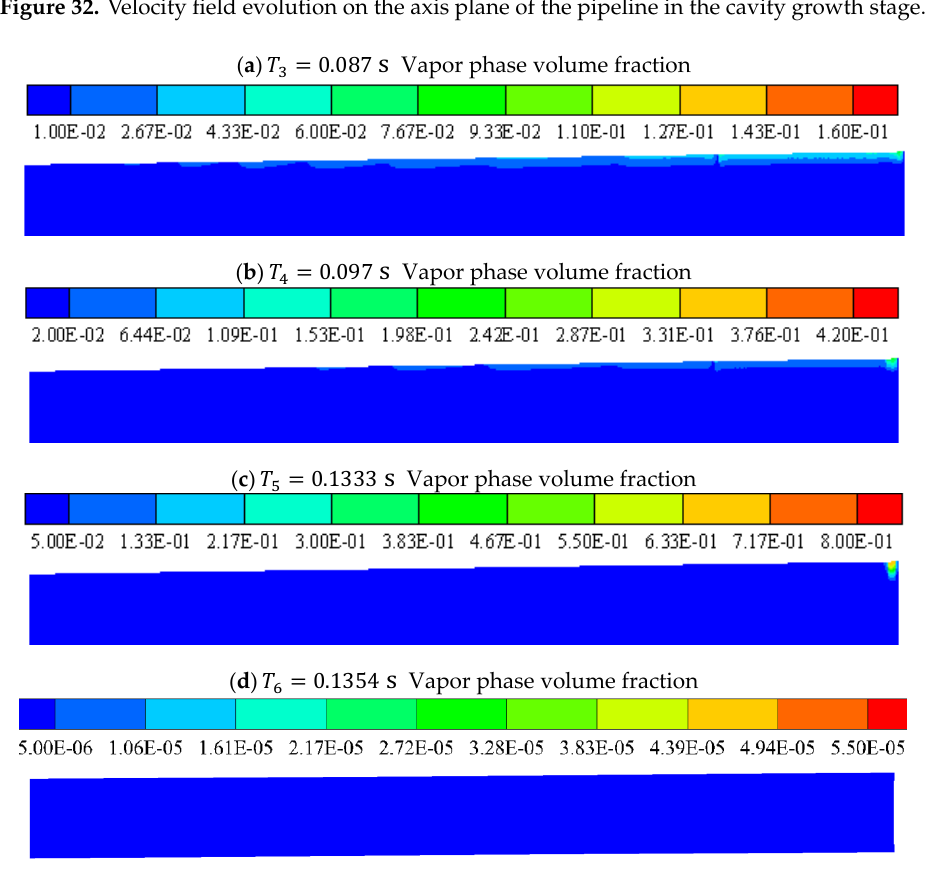
Figure 32. Velocity field evolution on the axis plane of the pipeline in the cavity growth stage.